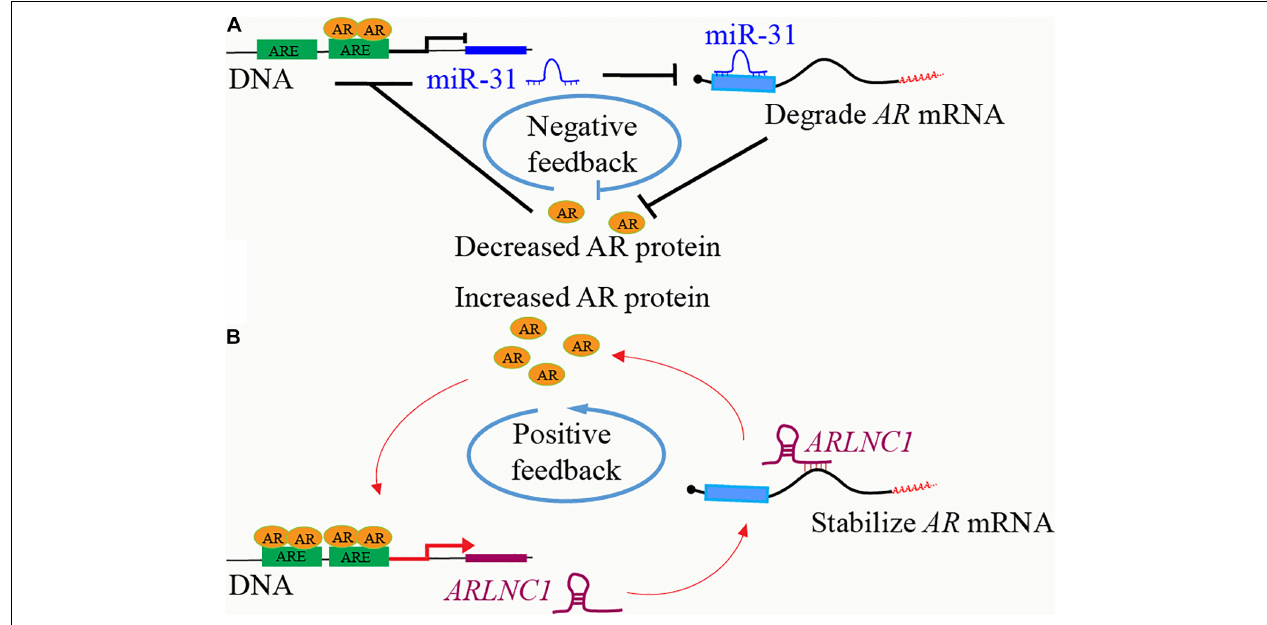
FIGURE 2 | Feedbacks between AR and ncRNAs. (A) AR binds to the promoter region of lncRNA ARLNC1 and induces its expression. ARLNC1 binds to and stabilizes AR mRNA, which increases AR expression and further activates the transcription of itself, ARLNC1, forming a positive feedback regulation loop. (B) AR binds to the promoter region of miR-31 and suppresses its expression. MiR-31 induces AR mRNA degradation via targeting the coding region of AR mRNA, thus forming a negative feedback regulation